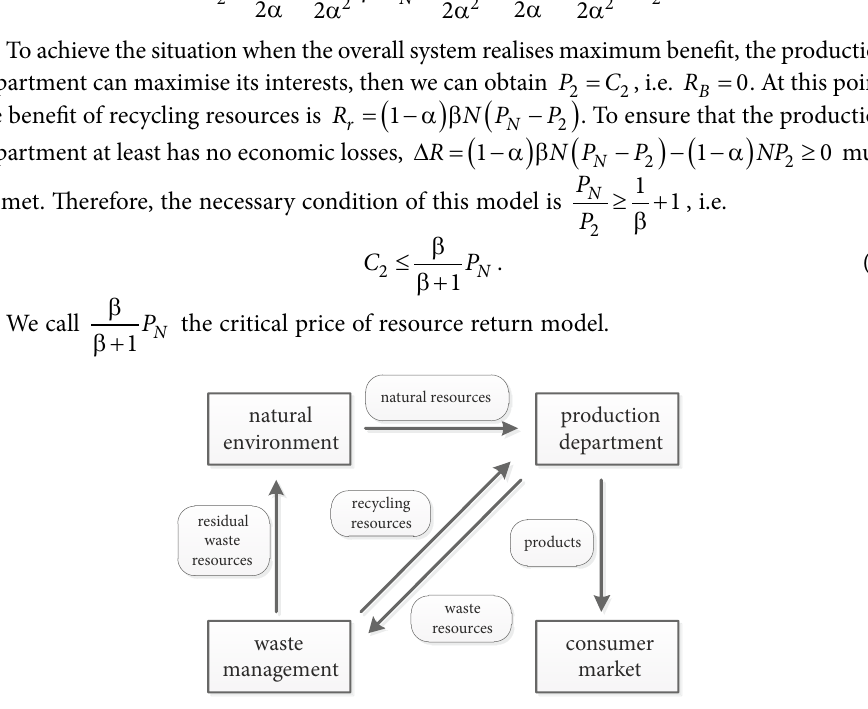
Figure 5. Recycling resource return model